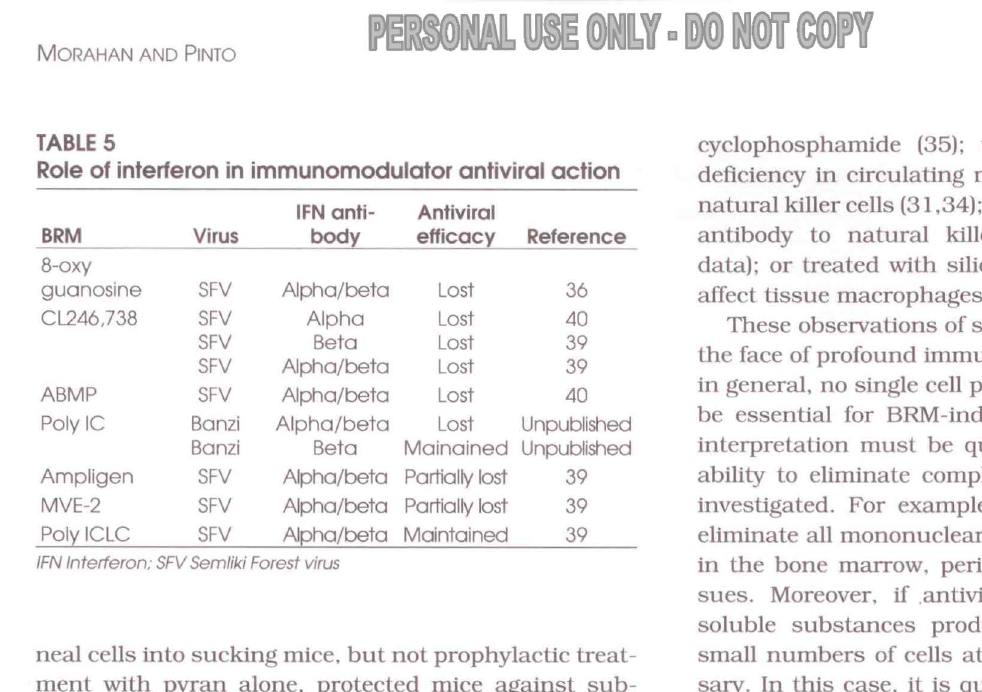
IFN anti- Antiviral